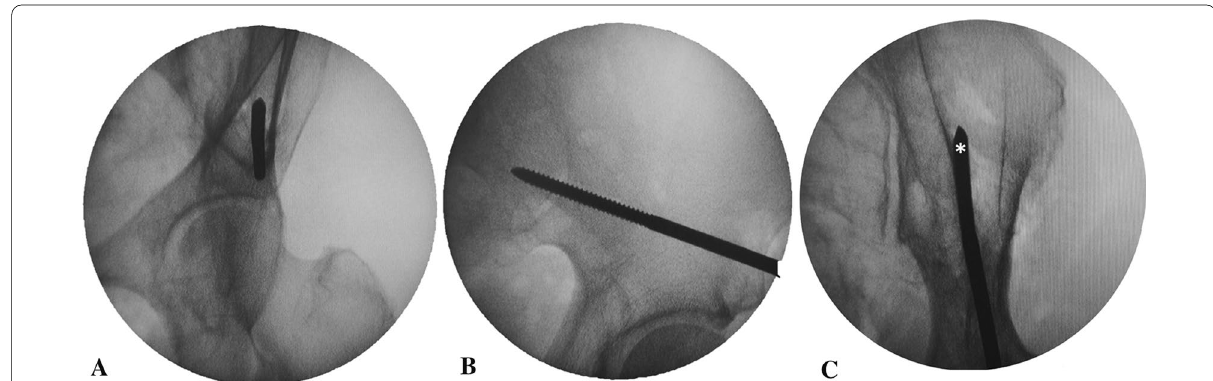
Fig. 4 Fluoroscopic image of pin placement on the left hemipelvis in the obturator outlet view ( A ), iliac oblique view ( B ), and obturator inlet view ( C ). The pin entry point is first identified in the obturator outlet view ( A ) in the center of the corridor of bone, and the pin is advanced using the iliac oblique view ( B ), with adjustment of the cephalad inclination angle above the sciatic notch ( A , B : percutaneous technique). Pin penetration outside the lateral cortex ( asterisk ) of the iliac bone was demonstrated on the obturator inlet view ( C : open